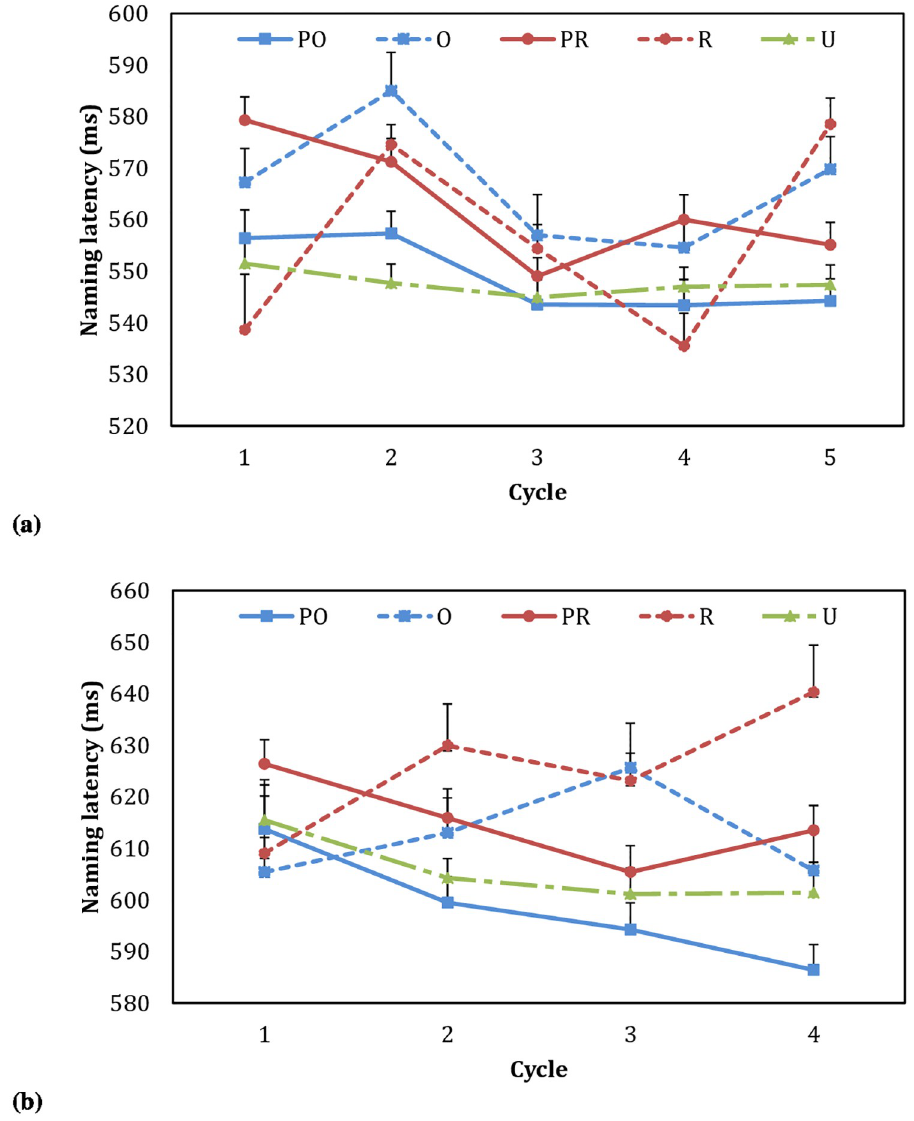
repetition; O, unpredictable onset repetition; R, unpredictable rhyme repetition; U, unrelated control. In Experiment 1, the O and the R conditions were mixed in the context of distributed segmental overlap, where a picture (e.g., 锤 /chui2/ “ hammer ”) could be preceded by another picture with onset overlap (e.g., 巢 /chao2/ “ nest ”) or rhyme overlap (e.g., 柜 /gui4/ “ cabinet ”) in their